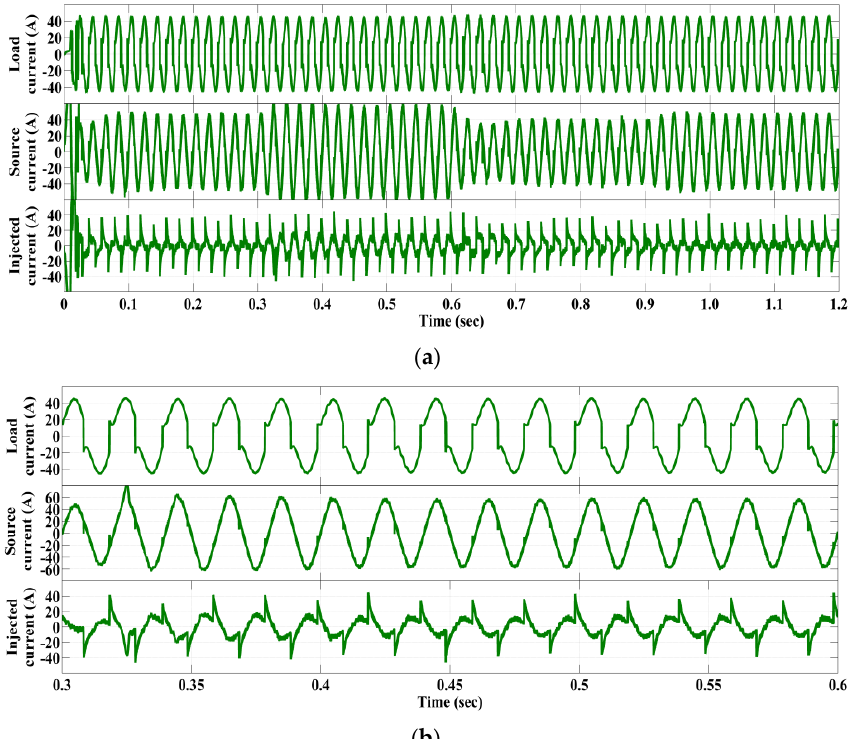
Figure 8. Simulation results with non ‐ linear load only: source current before compensation, source current after compensation and injection current from shunt APF (top to bottom) at ( a ) 0–1.2 s and ( b ) 0.3–0.6 s.